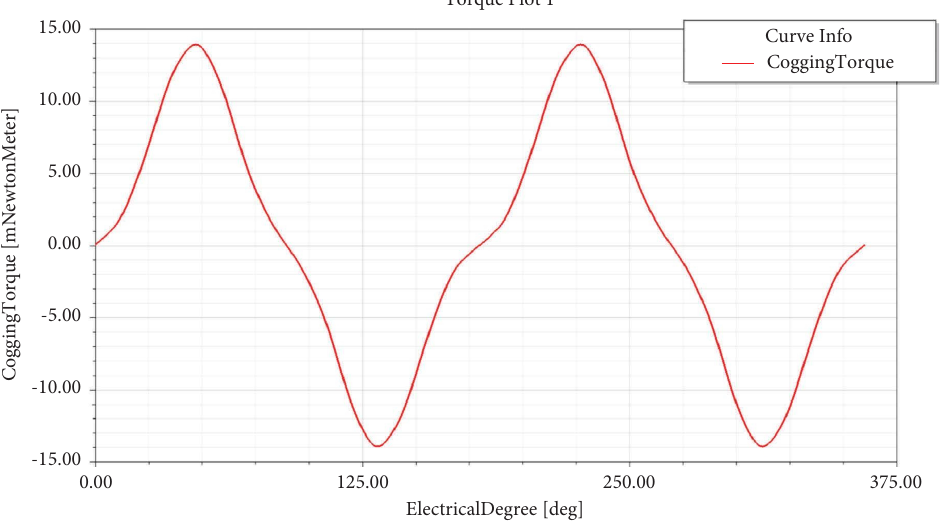
Figure 6: Torque curve of 2-pole 24-slot motor.